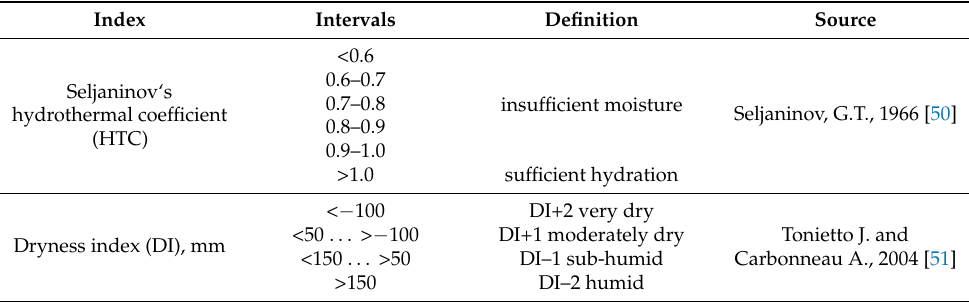
Table 1. Classes of indices used in the